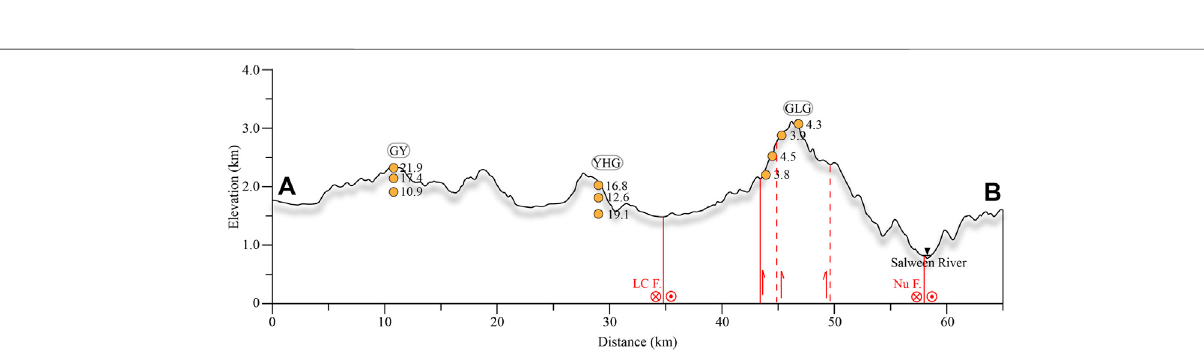
Frontiers in Earth Science |